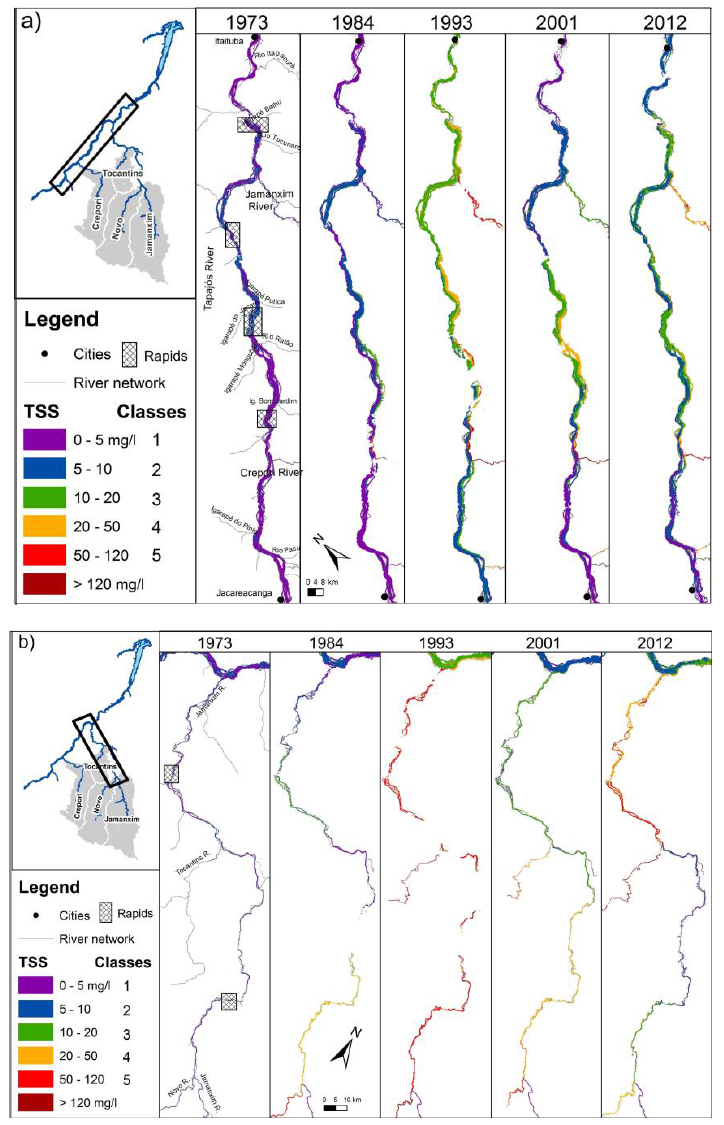
Figure 11. Spatio-temporal distribution of TSS along the Tapajós ( a ) and Jamanxim rivers ( b ). Sections of the river with rapids that often cause water mixing are also indicated. TSS maps based on five mosaics of satellite images: 1973 (Landsat-MSS), 1984, 1993, 2001 (Landsat-TM), and 2012 (IRS/LISSIII). All images are from the dry season (August to October); see [12] for more